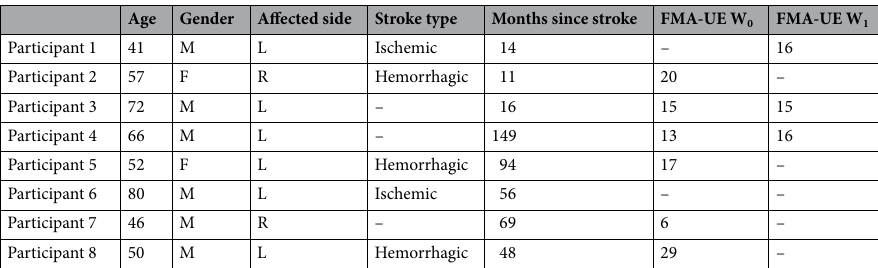
Table 1. Demographic and clinical information for participants with stroke. Months since stroke is the time between last known well and the baseline week W 0 . FMA-UE is the Fugl-Meyer Assessment of the upper extremity. Participants 1–4 underwent the sweeping task twice: once during the baseline week W 0 and again during a later week W 1 . Some demographic and clinical information were not available.